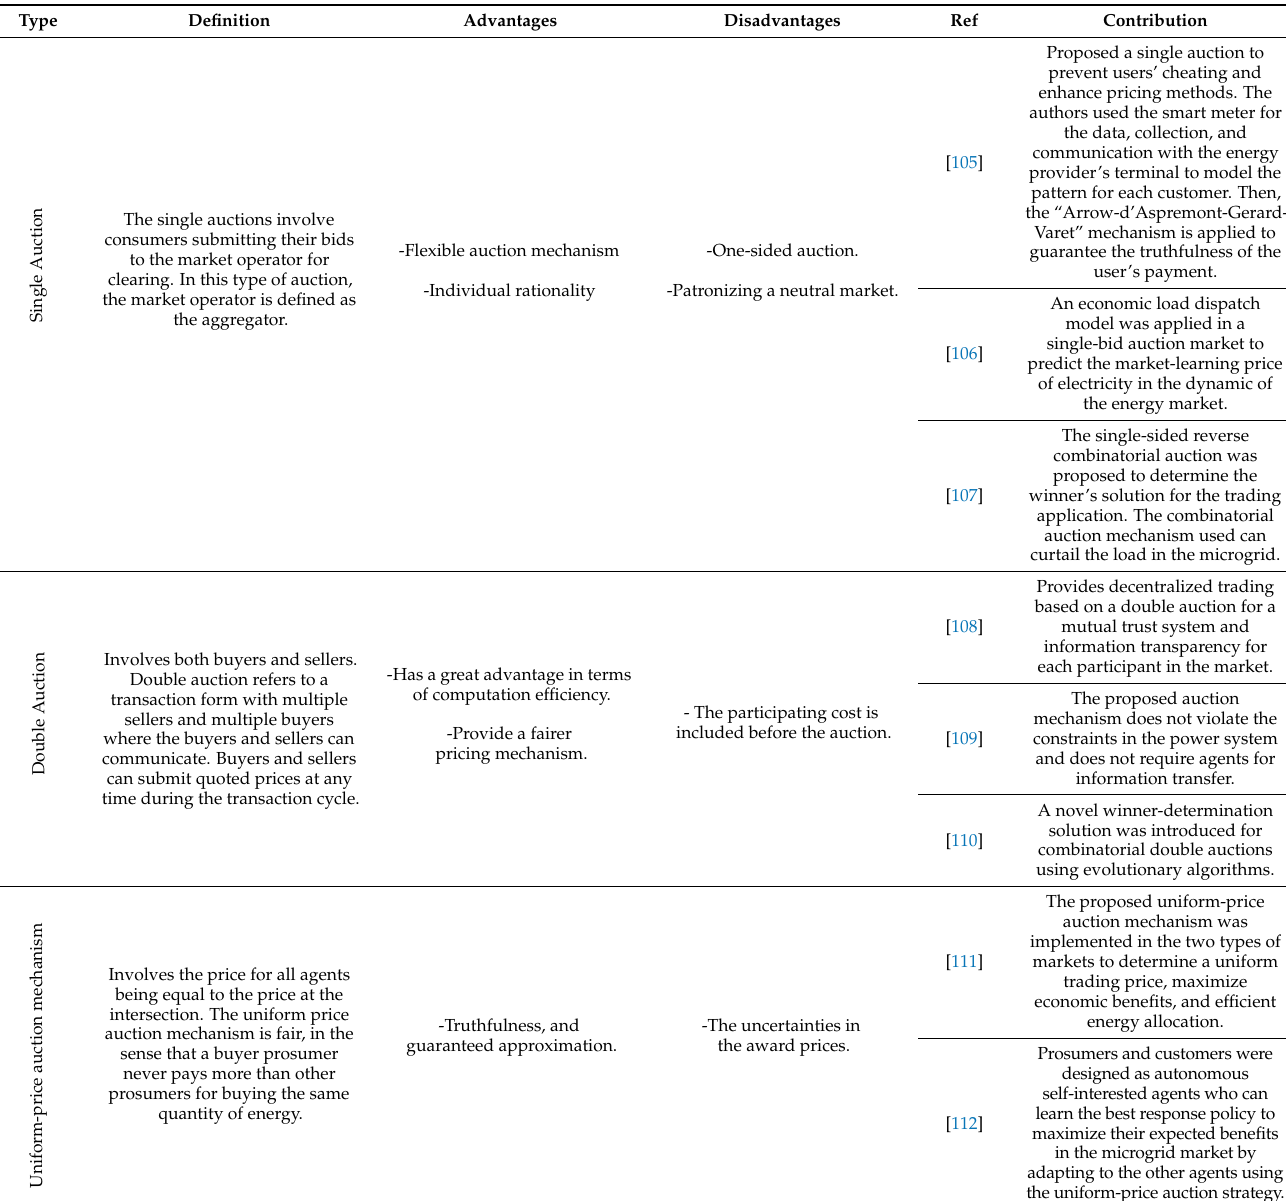
Table 2. Summary of the typical auction price formation mechanism in the energy